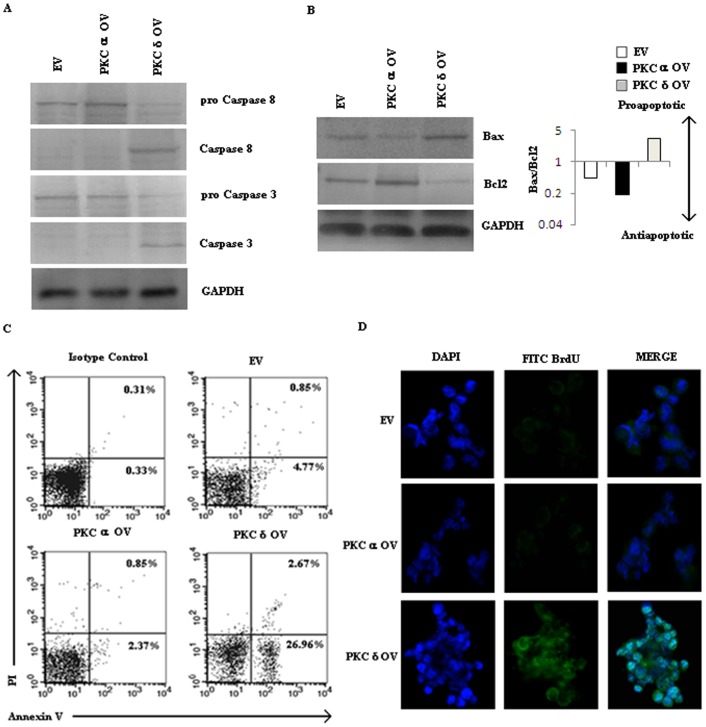
Regulatory effect of PKCα and PKCδ on caspase cascade and apoptosis.(A) Whole cell lysates of B16F10 cells, transfected with empty vector (EV), full-length mouse PKCα (PKCαOV) and PKCδ (PKCδOV) plasmid as mentioned in materials and methods were probed by Western blotting to study the expression of pro Caspase 3, Caspase 3, pro Caspase 8, and Caspase 8. Representative data from three independent experiments was shown compared to GAPDH. (B) Whole cell lysates of B16F10 cells, transfected with empty vector (EV), full-length mouse PKCα (PKCαOV) and PKCδ (PKCδOV) plasmid were probed by Western blotting to study the expression of Bax and Bcl2 respectively. The ratio of Bax (proapoptotic)/Bcl2 (antiapoptotic) were represented on a log scale. (C) Similarly B16F10 cells, transfected with control vector (EV), full-length mouse PKCα (PKCαOV) and PKCδ (PKCδOV) plasmid as mentioned in materials and methods were stained with Annexin-V FITC and PI and analyzed by flow cytometry. Data represented here are from one of three independent experiments. (D) B16F10 cells, transfected with control vector (EV), full-length mouse PKCα (PKCαOV) and PKCδ (PKCδOV) plasmid as mentioned in materials and methods were stained with FITC-BrdU for tunnel assay and analysed by immunofluorescence microscopy.